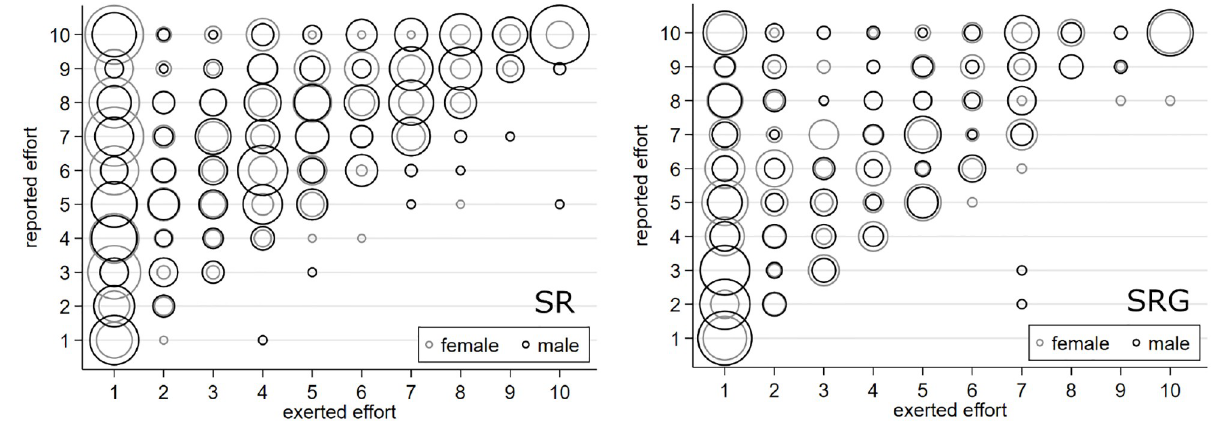
Fig 4. Frequency of certain combinations of exerted and reported effort